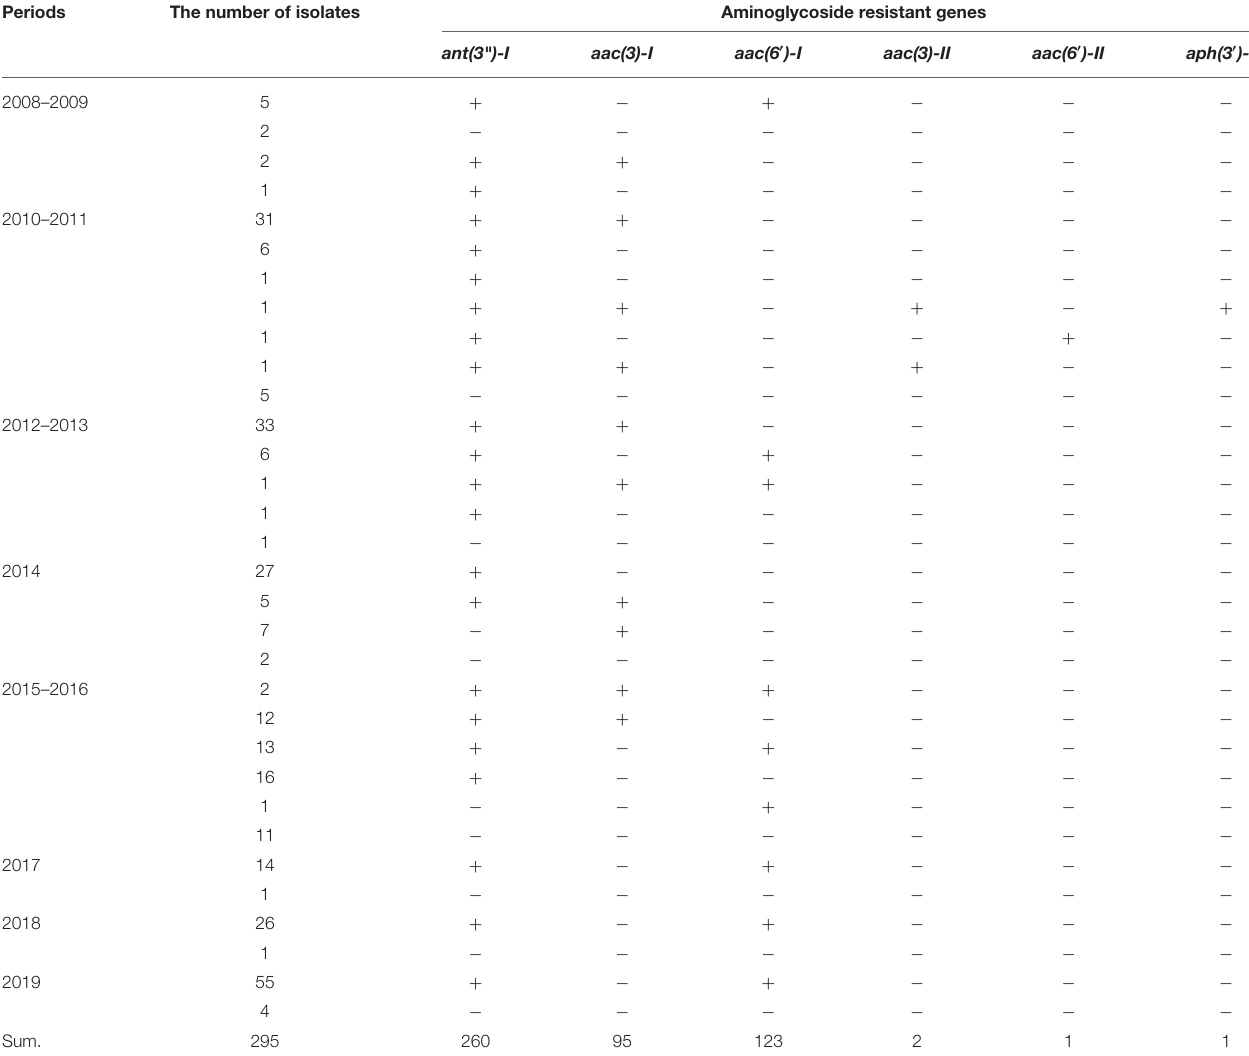
TABLE 6 | The profiles of the aminoglycoside resistant genes of 295 MDR A. baumannii isolates. Periods